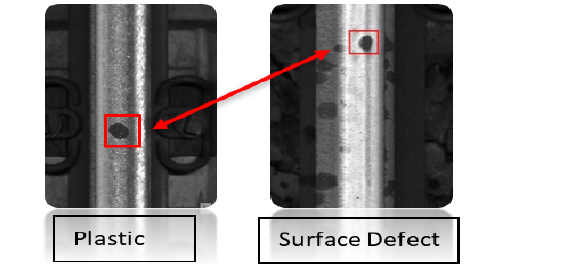
Figure 6. Difficulty in detecting defects based on image data with